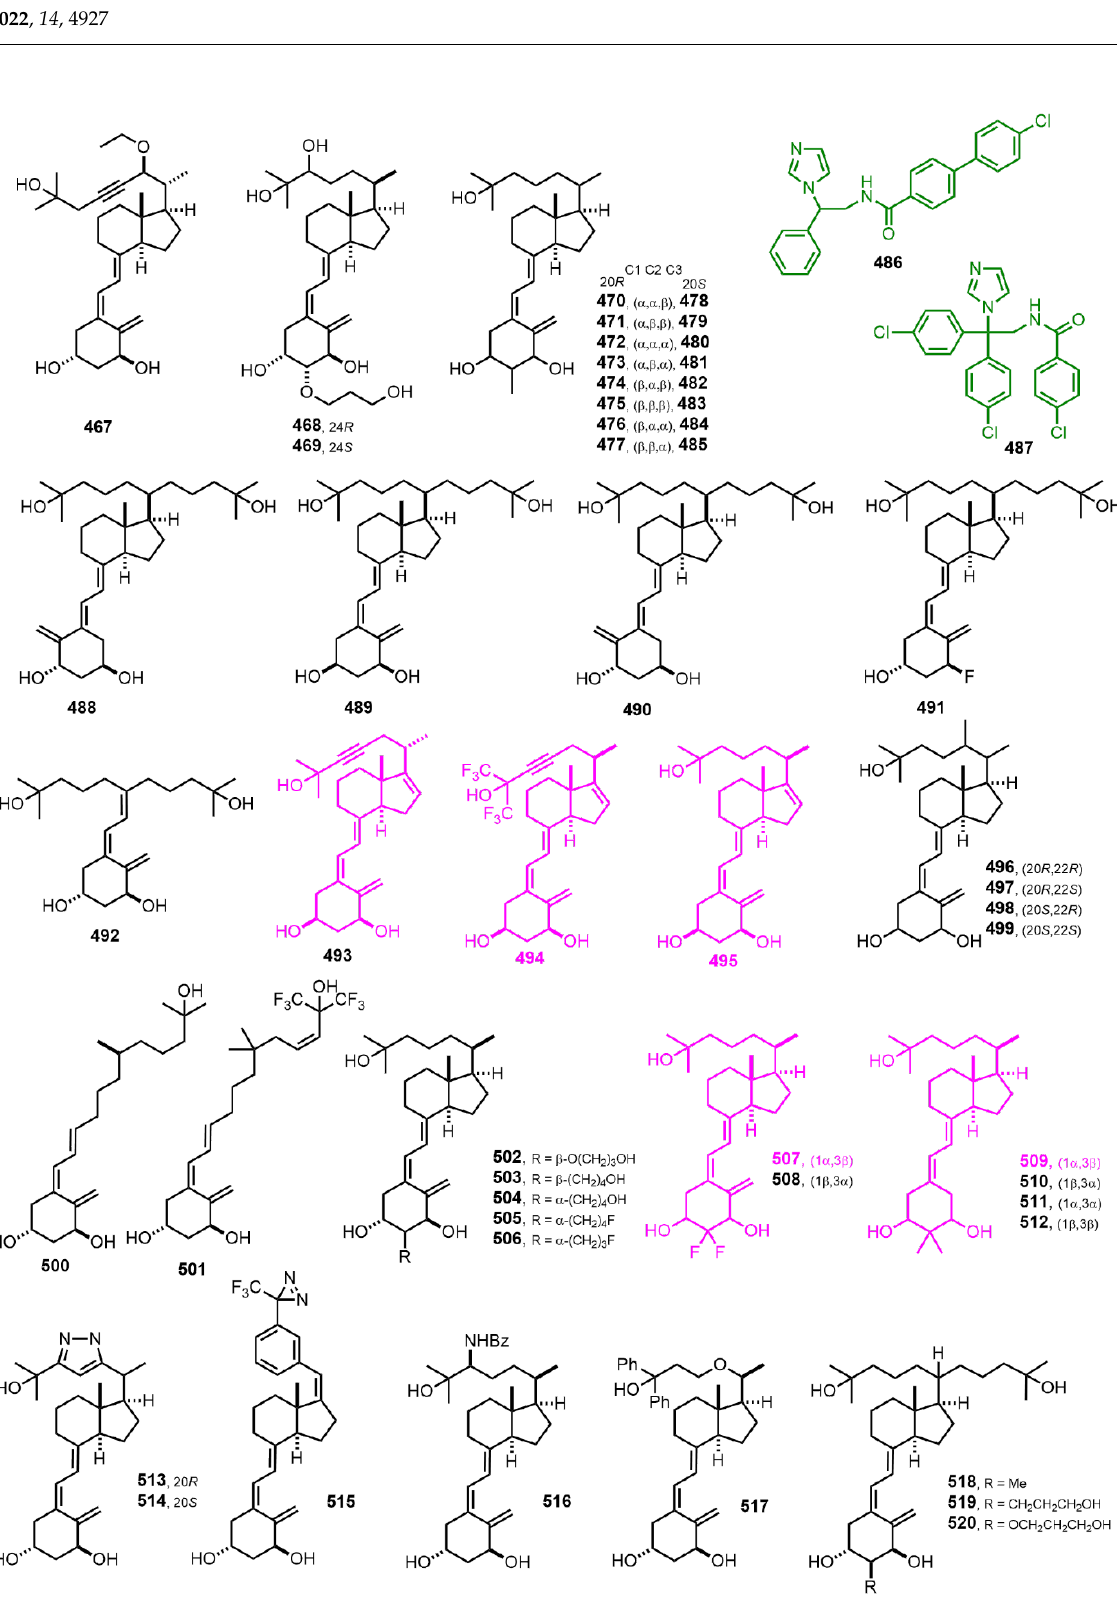
Figure 11. (2001–2002)